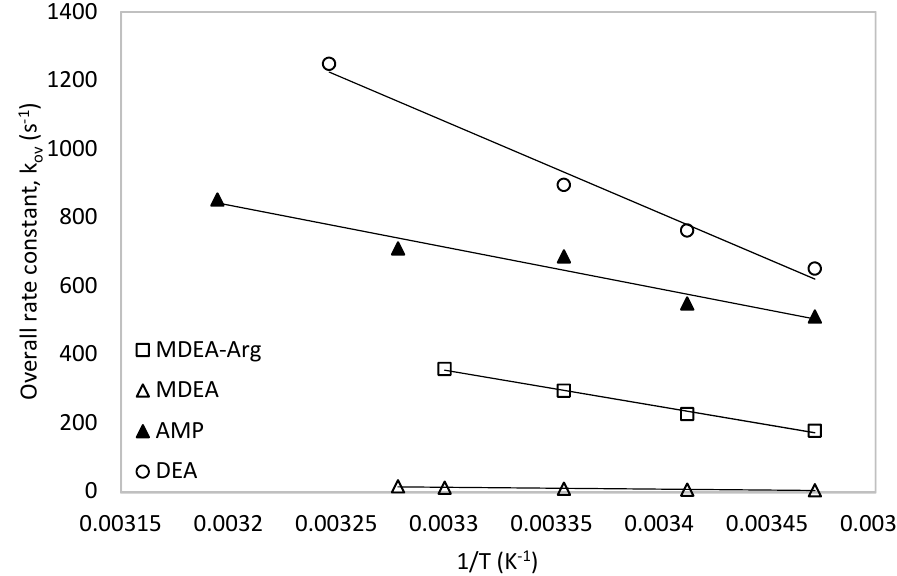
Figure 12. Comparison of the obtained data with MDEA-Arg with other amine systems.